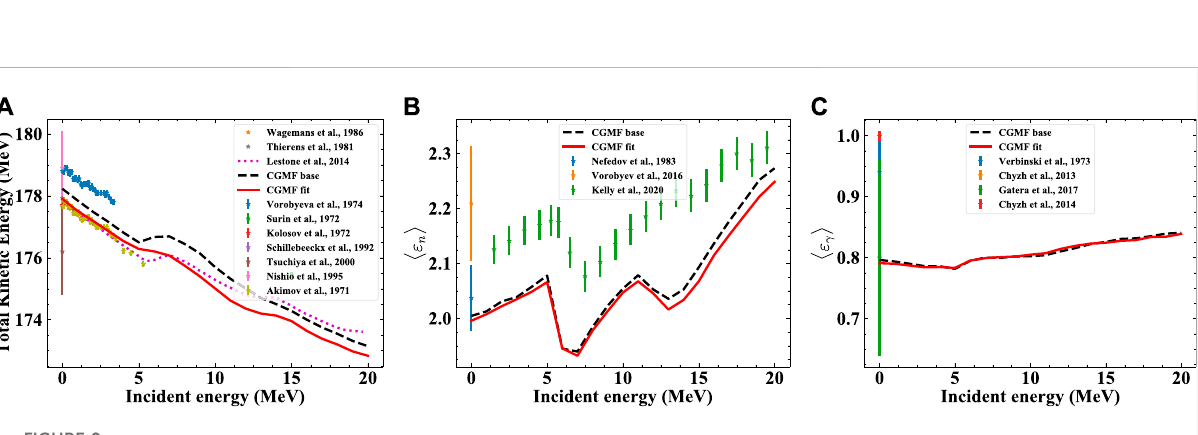
FIGURE 9 CGMF baselinecalculation, evaluated CGMF calculation, and experimental data are comparedfor several observables: (Left) Total kineticenergy, TKE, as a function of incident neutron energy. The curve of Lestone et al. is a phenomenological model calculation informed by experimental data. (Center) Average outgoing energies of the prompt neutrons and (right) γ rays as a function of incident neutron